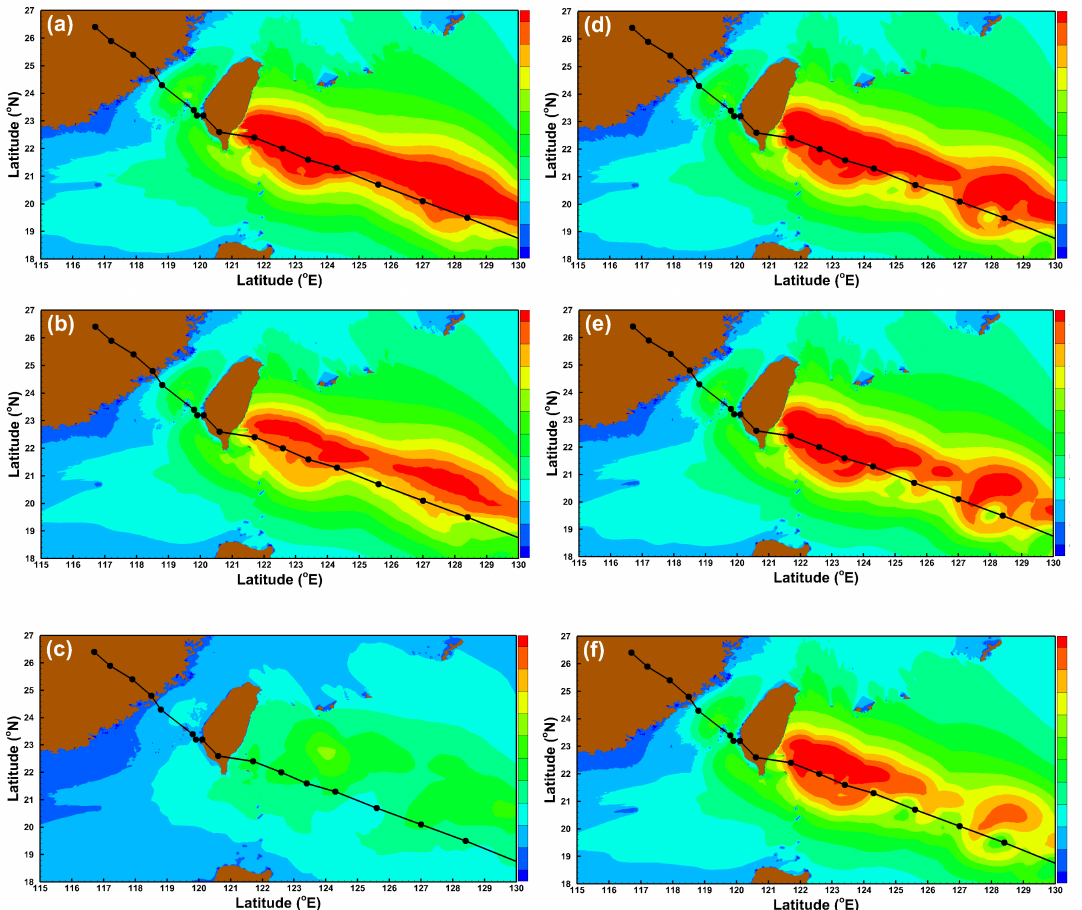
Figure 13. Spatial distribution of maximum SWHs driven by winds from the hourly CFSV2 with spatial resolutions of ( a ) 0.205 ◦ , ( b ) 0.5 ◦ , and ( c ) 1.875 ◦ and from CFSV2 with a spatial resolution of 0.205 ◦ and temporal resolutions of ( d ) 2 h, ( e ) 3 h, and ( f ) 6 h for Super Typhoon Nepartak in